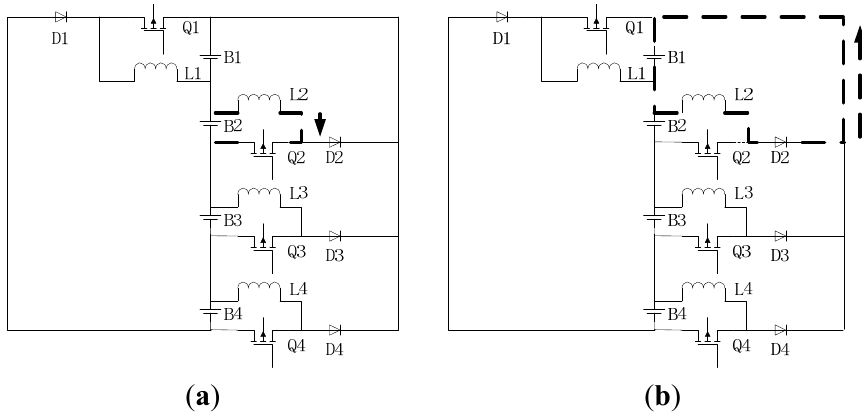
Figure 4. Current path from B to L ; ( b ) When Q B (cid:2870) (cid:2870)